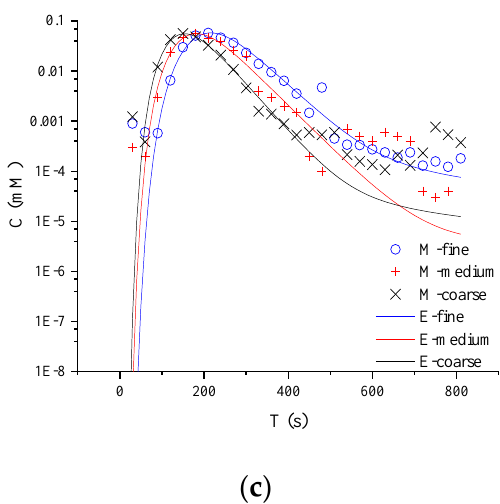
Figure 3. Semi-logarithmic coordinate curves of product NQAB under different media particle sizes: ( a ) refers to 40.063 mL / min; ( b ) refers to 60.094 mL / min; ( c ) refers to 80.126 mL / min (M is the measured concentration and E is the predicted concentration).